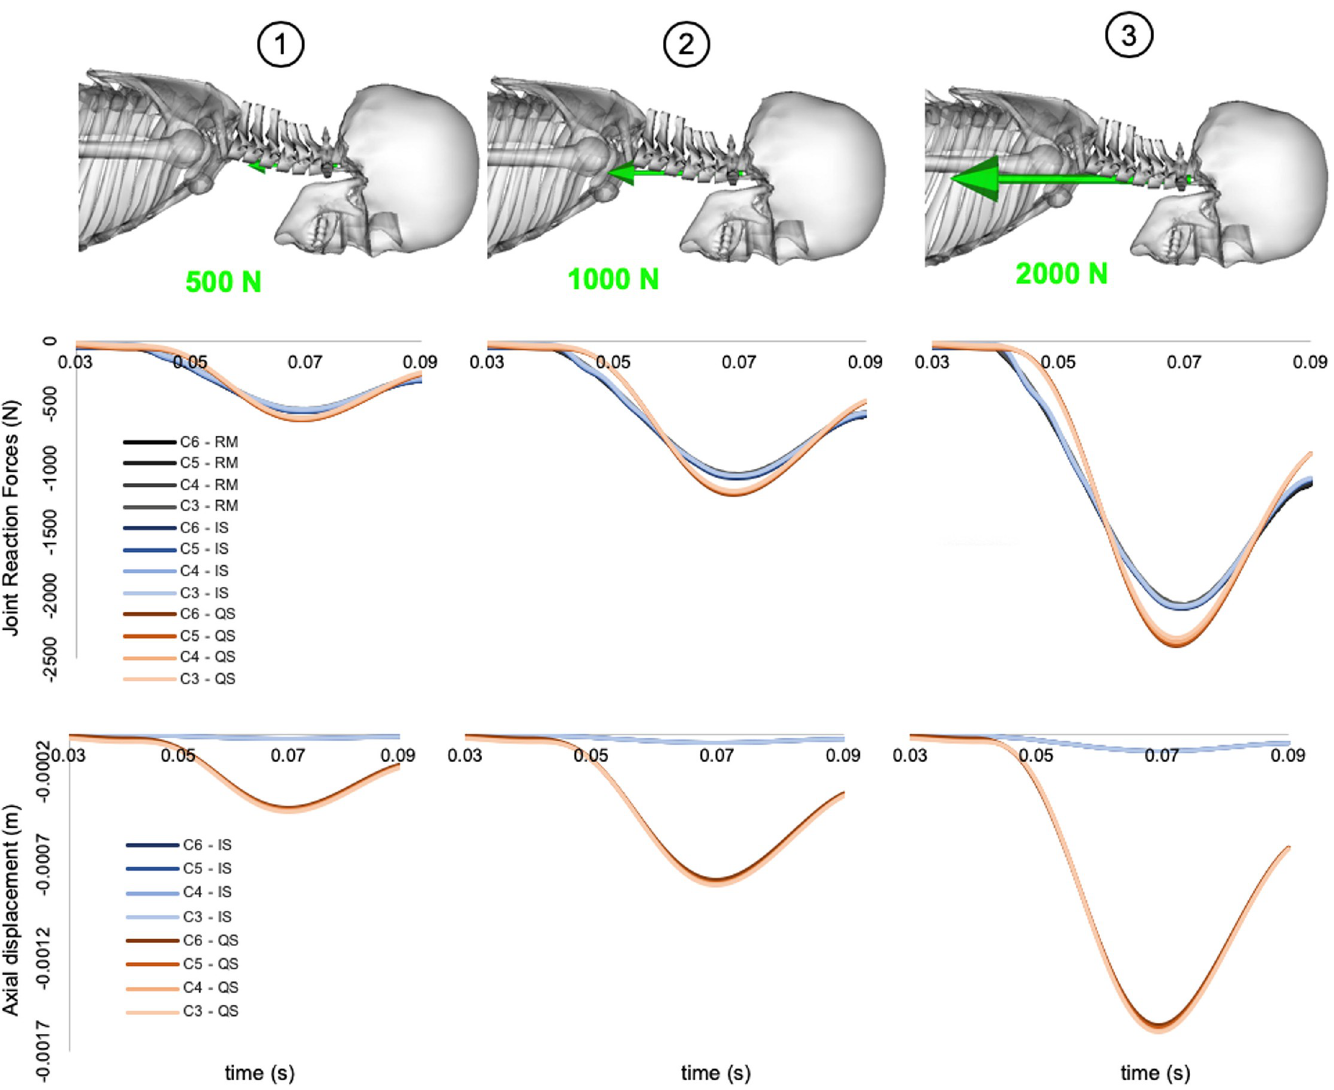
Fig 7. Forward dynamic results of theoretical injurious sporting scenario. Comparison of internal joint loads (Row 2) and resulting joint displacements (Row 3) calculated from the three versions of the musculoskeletal model and across three loading conditions (Row 1). Only joint loads are displayed for the Rugby Model (RM) as the kinematic constraints do not allow for joint translation which is displayed for Impact Specific (IS) and Quasi-Static (QS) versions of the model.